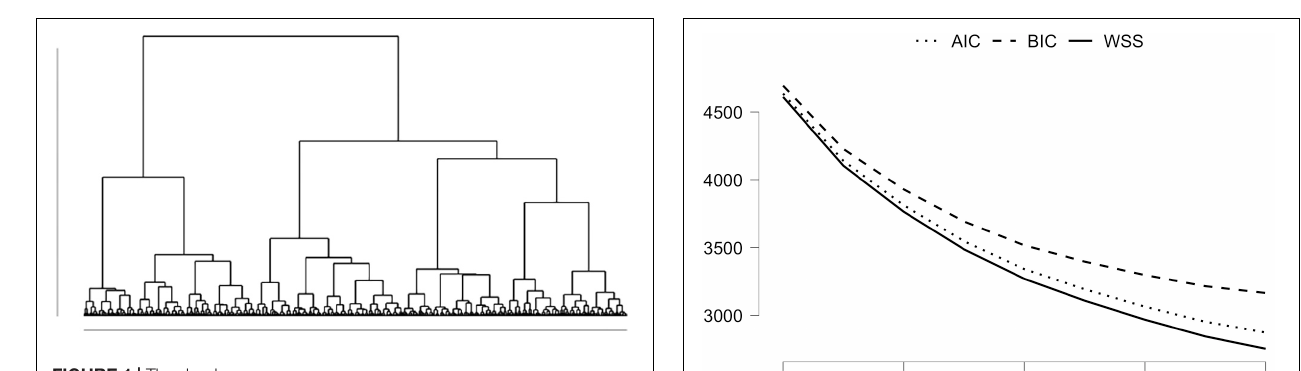
FIGURE 1 | The dendrogram.